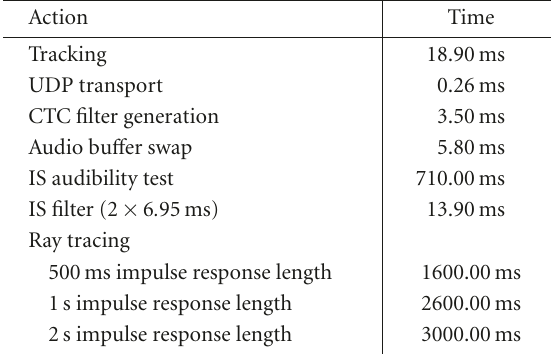
Table 4: Overview of performance measurements of the several